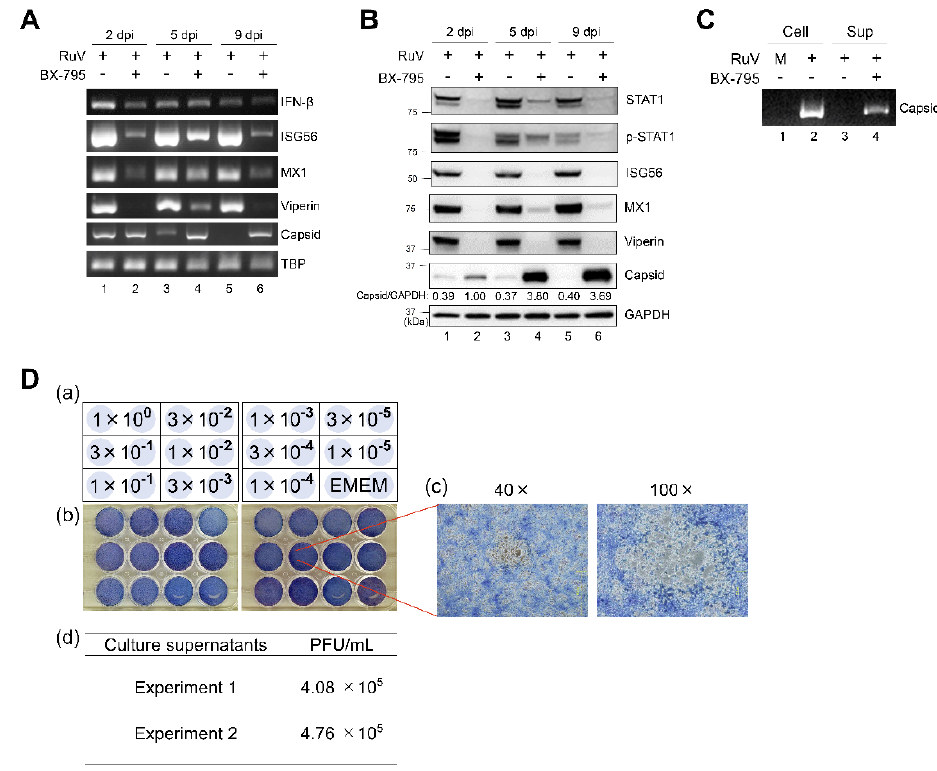
Figure 6. Effect of BX-795 on the RuV-triggered innate immune response and the production of infectious progeny virions. ( A ) Total RNAs extracted from RuV-infected U373MG cells (MOI of 1.8) pretreated with a TBK1/IKK ε inhibitor BX-795 (10 µ M) (+) or DMSO ( − ) for 3 h were harvested at the indicated times postinfection and subjected to RT-PCR for the detection of IFN- β , ISG56, MX1,